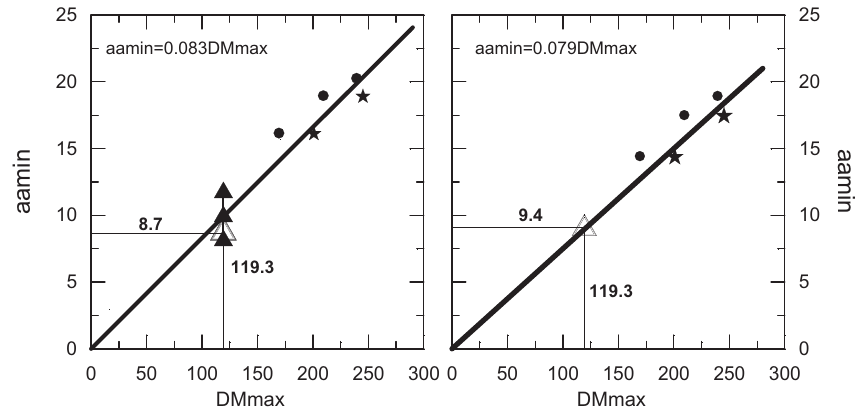
Fig. 3. Geomagnetic index at minimum, aa min , vs. observed maximum amplitude of the dipolar field strength, DM max . The ordinates of the stars and dots are the observations of DM max as deduced from Mount Wilson and Wilcox solar observatories data, respectively. The abscissae are the yearly values of the standard aa index (left-hand panel) and the homogenized data from Lockwood (2009, priv. comm.). The filled triangles in the left-hand panel are a measure for the prediction of aa min #24 as derived from the regression line and the value of DM max for cycle 24 (De Jager & Duhau 2009) and the open triangle is the observed value. The open triangle in the right-hand panel is the value of aa min obtained from the corresponding regression line. This diagram proves that aa min is a suitable proxy for the polar